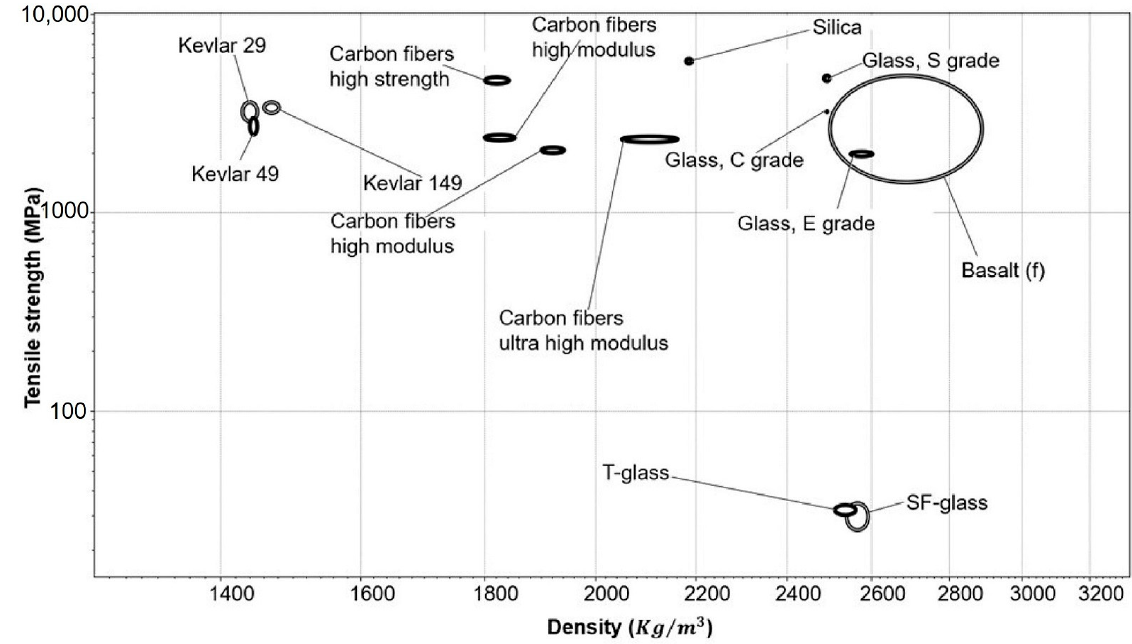
Figure 2. Tensile Strength versus Price (Generated by CES EduPack, 2015).